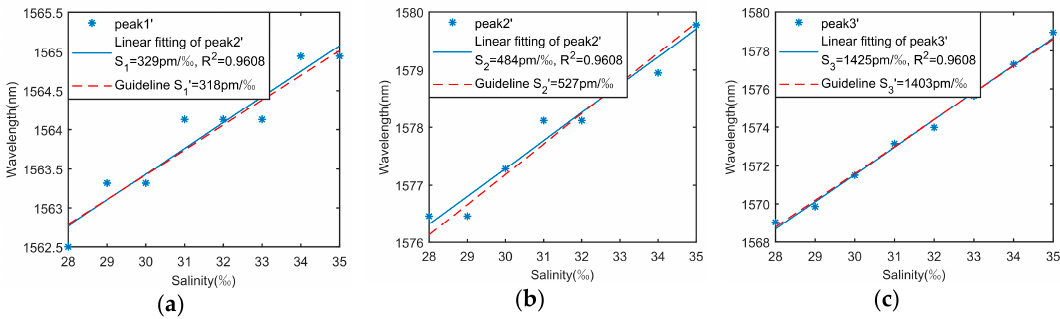
Figure 6. Linear fitting result of peaks. The red lines represent the peak wavelengths’ shift under an arm difference of zero; ( a ) linear fitting of peak1 ′ , ( b ) linear fitting of peak2 ′ and ( c ) linear fitting of peak3 ′ .